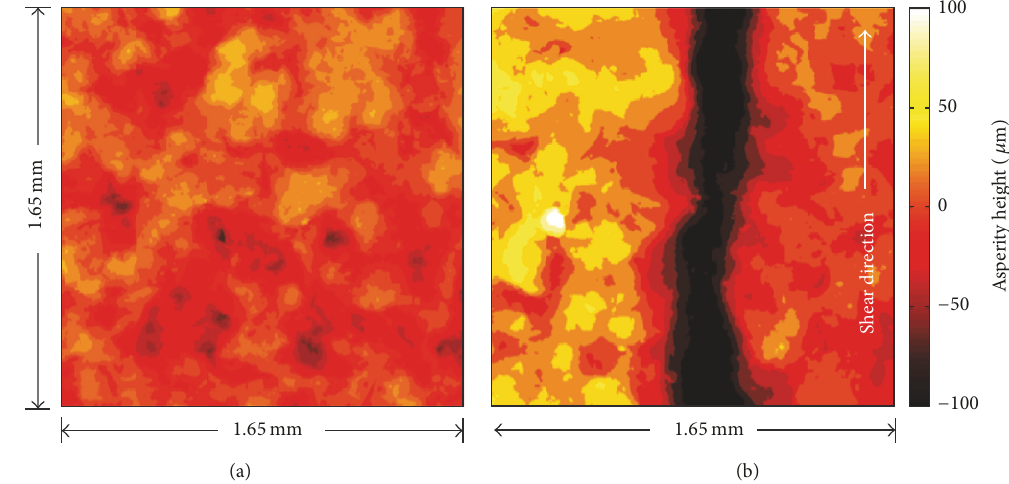
Figure 8: White light profilometry of fracture surface (a) before shearing (Figure 7(a)) and (b) after shearing at 5MPa normal stress (Figure 7(d)). The dark channel represents a striation with a depth of ∼ 100 𝜇